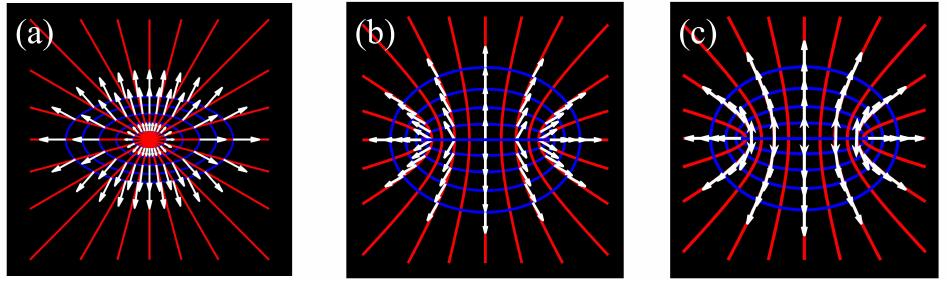
Figure 1. Polarization structure of the three elliptic-symmetry vector beams. ( a , b ) are the elliptic- symmetry vector beams reported in [7,8], respectively. ( c ) is the ESRP beam reported in this